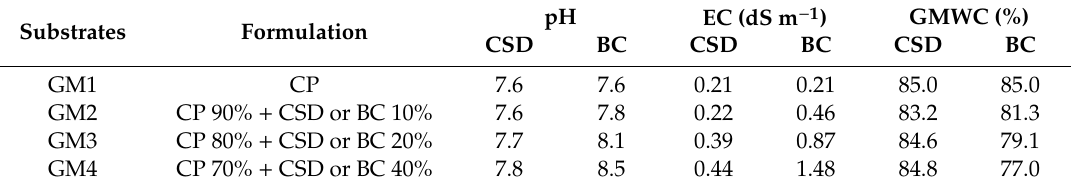
Table 3. Growing media assayed on grapevine planting